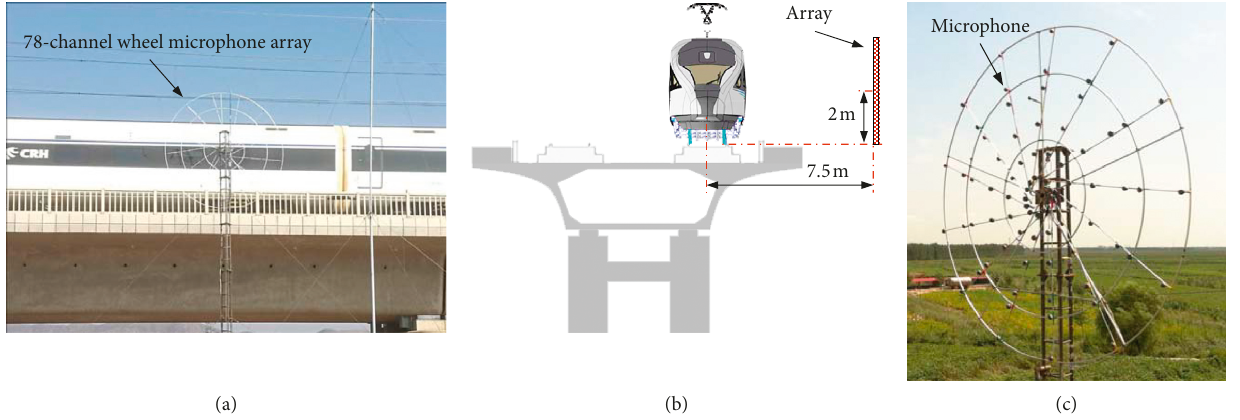
78-channel wheel microphone array